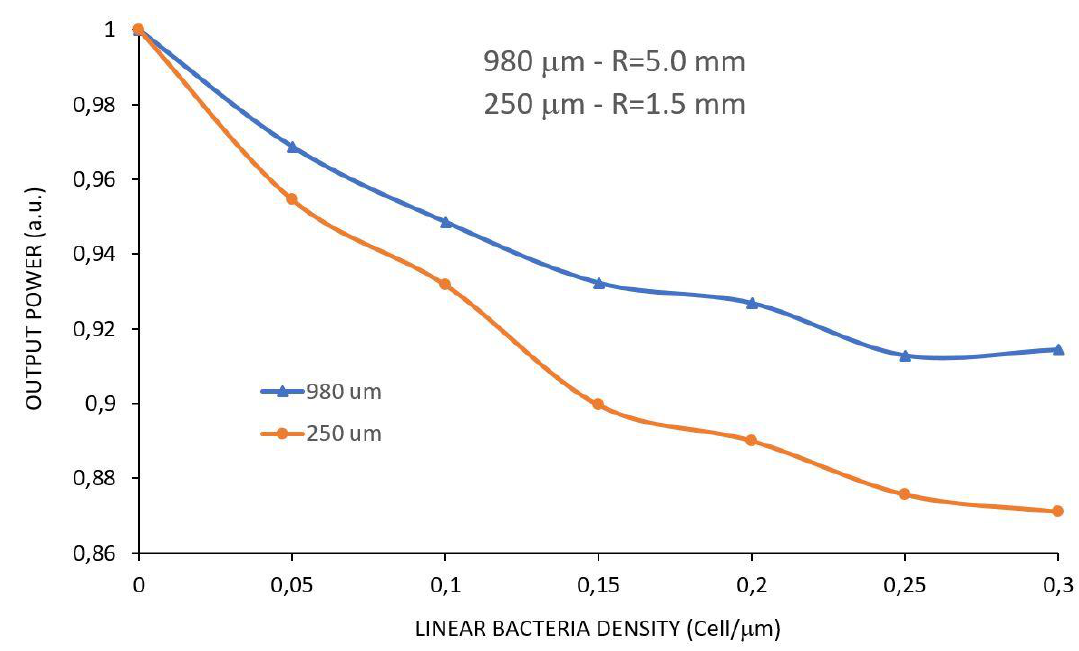
Figure 7. Simulations for φ = 980 µ m with R = 5.0 mm and φ = 250 µ m with R = 1.5 mm of U-Shaped sensors for a crescent bacteria density along the fiber